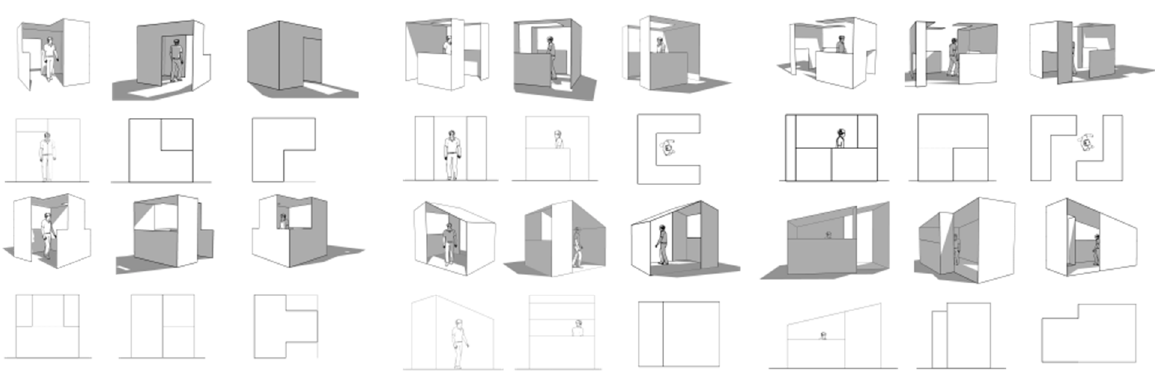
Figure 7. Architectural spaces to be drawn using immersive virtual reality.